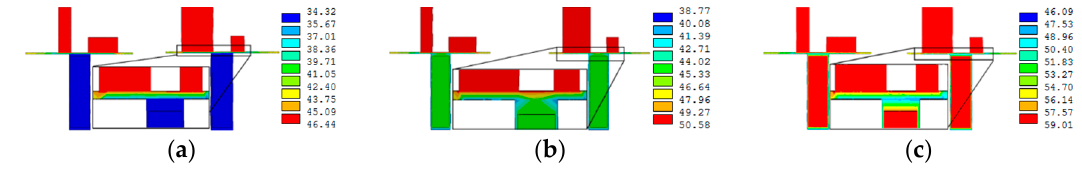
Figure 16. Temperature distributions of the axial field structure under different AMMF (°C); ( a ) 0At AMMF; ( b ) 600 At AMMF; and, ( c ) 900 At AMMF.